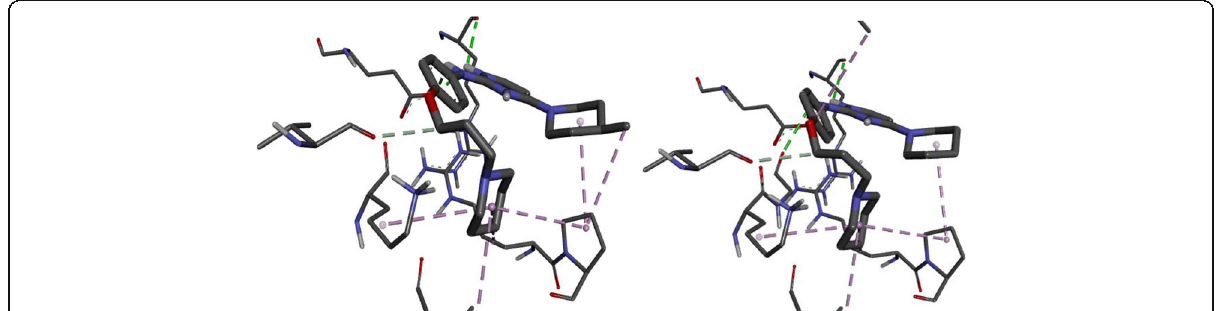
Fig. 8 Ligand interactions of complexes 15 and 18 in a 3D